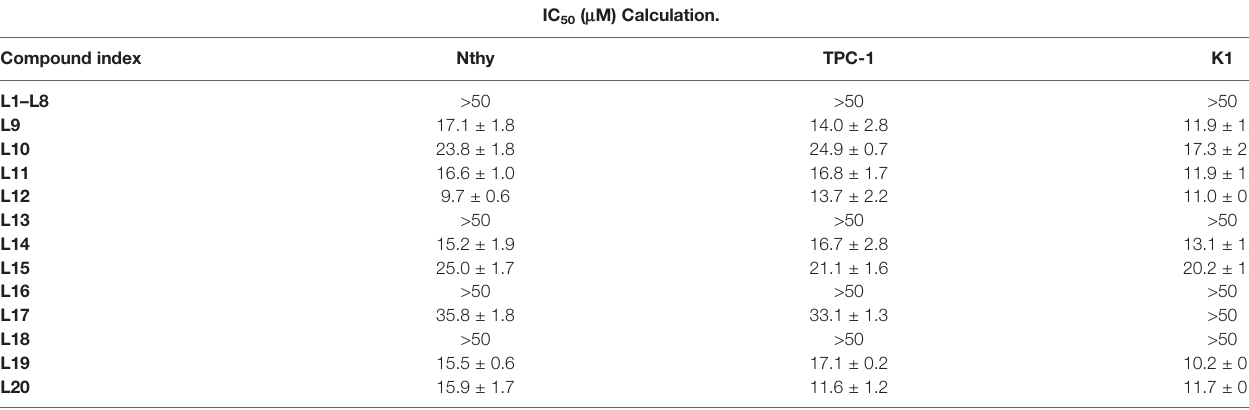
TABLE 2 | Antiproliferative effects of novel compounds Mito-Fu L1-L20 on normal thyroid and papillary thyroid carcinoma cell lines. IC 50 ( m M)